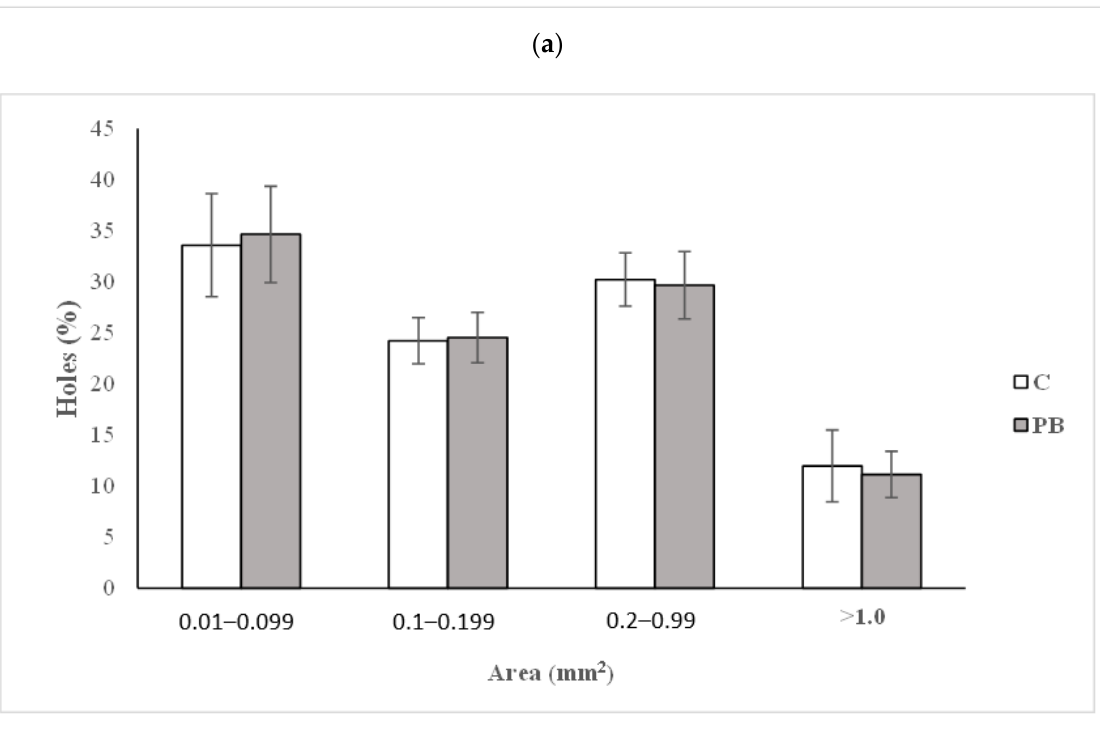
Figure 4. ( a ) Number of holes (%), mean and standard deviation, for the selected dimensional clasScheme 0. 099; 0.1–0.199; 0.2–0.99; >1.0) in fresh (day 0) control (C) and parchment bread (PB). ( b ) Number of holes (%) belonging to classes 0.01–0.09 mm 2 and 0.2–0.99 mm 2 in PB during storage. Different small and capital letters, for the two classes, respectively, are significantly different ( p < 0.05).